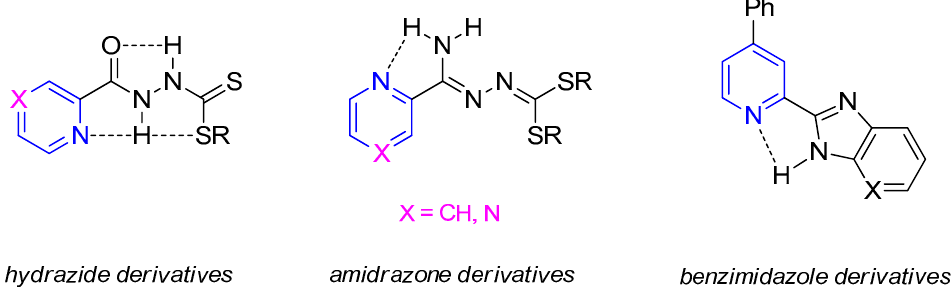
Figure 1. Structures of pyridine and pyrazine derivatives with proven activity against M. tuberculosis .